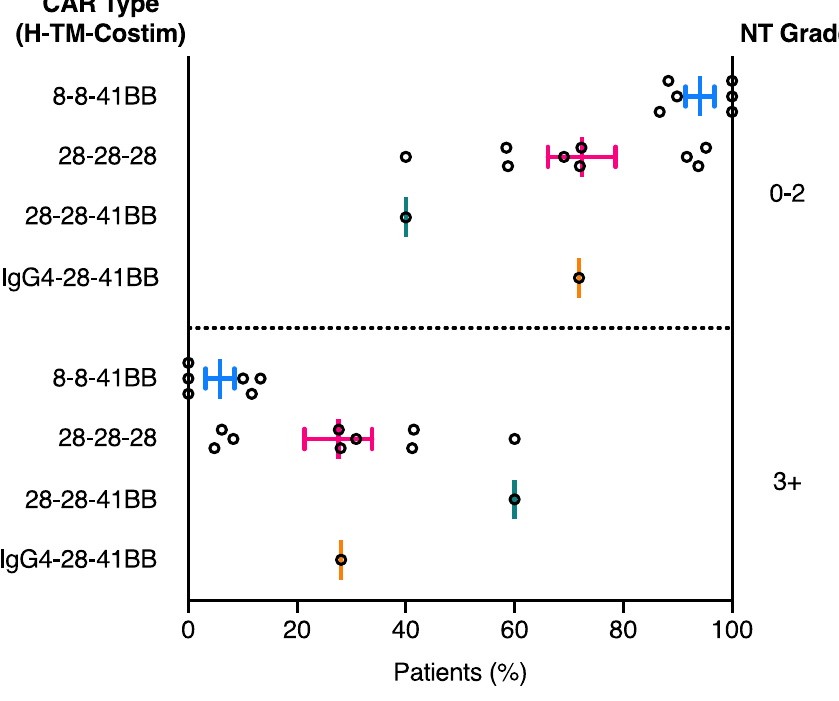
Figure 4. Grade of neurotoxicity development in patients treated with CD19 CAR T cell therapies is related to CAR domain structure composition. CAR domain structure is separated based on hinge (H), transmembrane (TM) and costimulatory (Costim) domain composition on the left y axis, while neurotoxicity grade is separated into grade 0–2 or grade 3+ on the right y axis. Each circle represents the percentage of patients in a single clinical trial listed in Table 1 that developed the corresponding grade of neurotoxicity (grade 0–2 and grade 3+). Middle line represents the mean percentage of patients with the corresponding grade of neurotoxicity and error bars represent the SEM (Table S3).